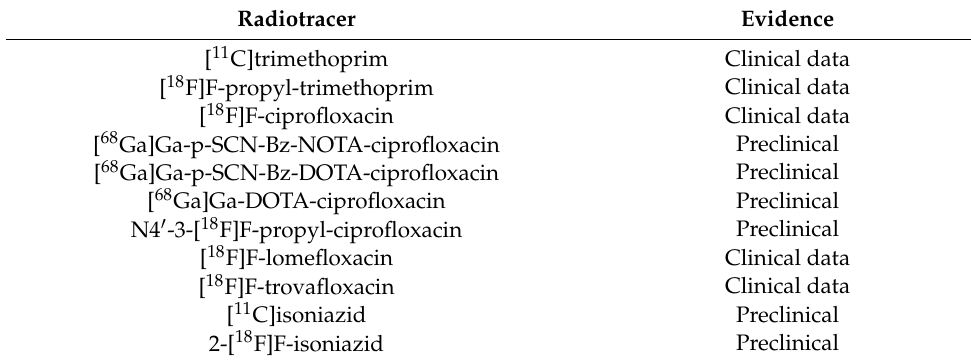
Table 4. Overview of antibiotic-derived PET